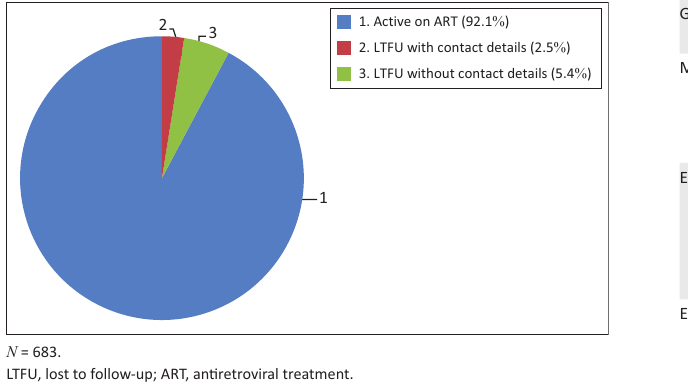
FIGURE 2: Overall proportion of patients lost to follow-up at Sediba Hope Medical Centre. TABLE 2: Distribution of patients according to CD4 + cell count results, based on testing done within 6 months of the patient’s final clinic visit prior to becoming lost to follow-up. CD4 + count (cells/ µ